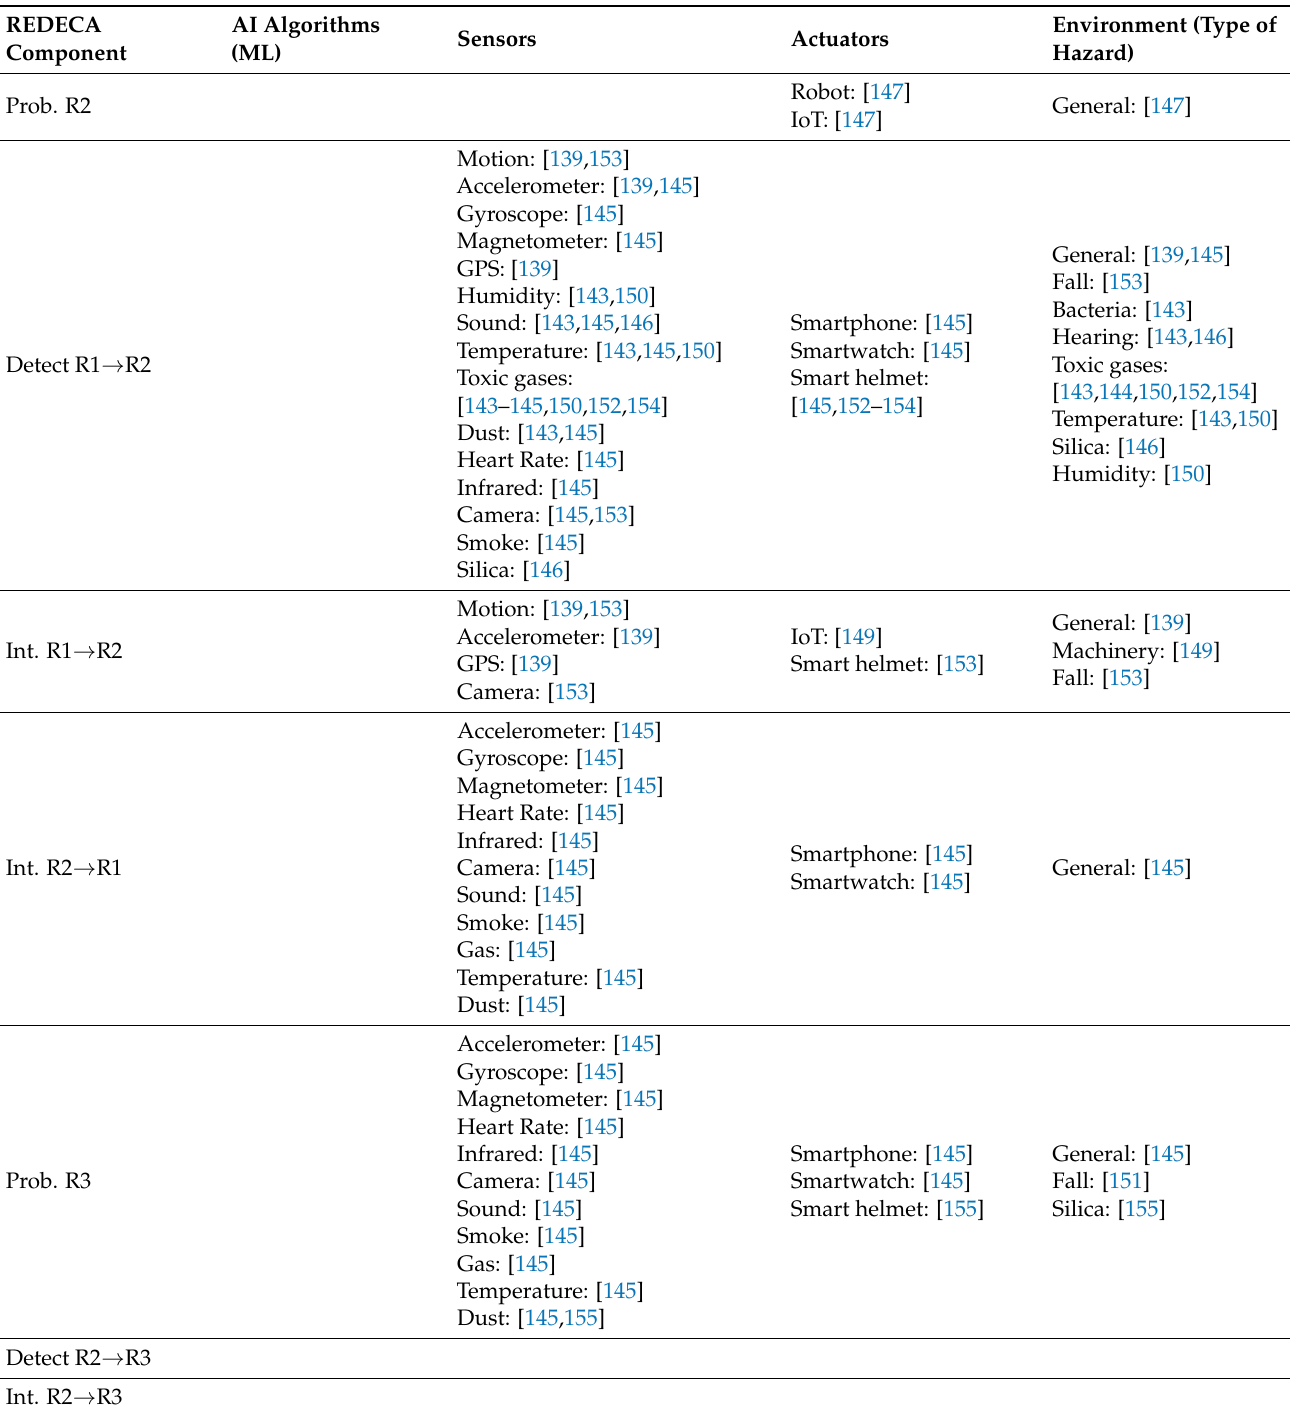
Table 6. Mining AI/OSH algorithm, sensor and actuator research organized by the REDECA framework. Major technologies described by each paper is mentioned and linked to the relevant papers [134–158]. Summary of each paper is found in Appendix